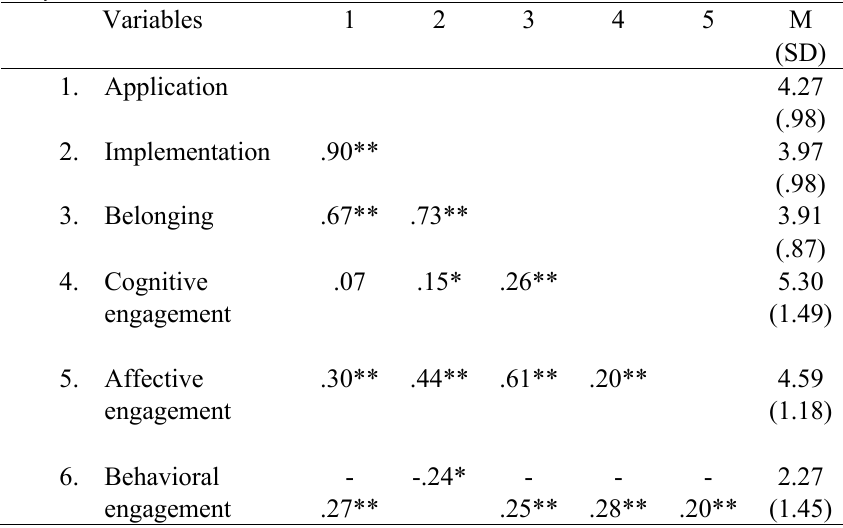
Descriptive statistics (means and SDs) and Pearson correlations among all study variables